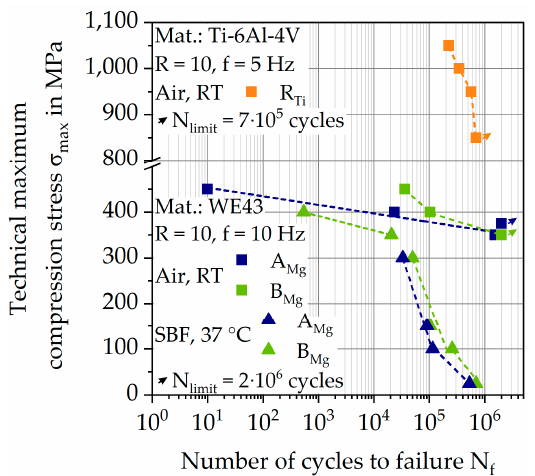
Figure 19. Trend S-N curves for batches A Mg and B Mg of magnesium and batch R Ti of titanium at RT and in SBF at 37 °C.